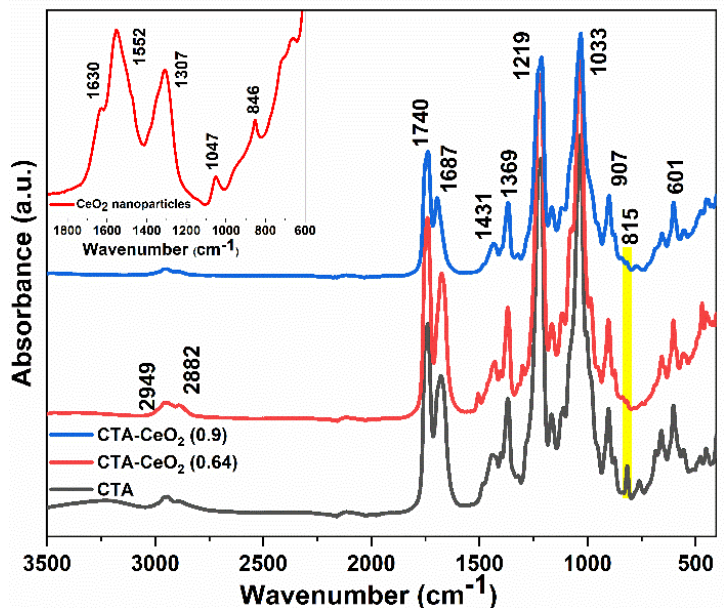
Figure 5. FTIR spectra of synthesized membranes with different concentrations of CeO 2 nanoparti- cles.